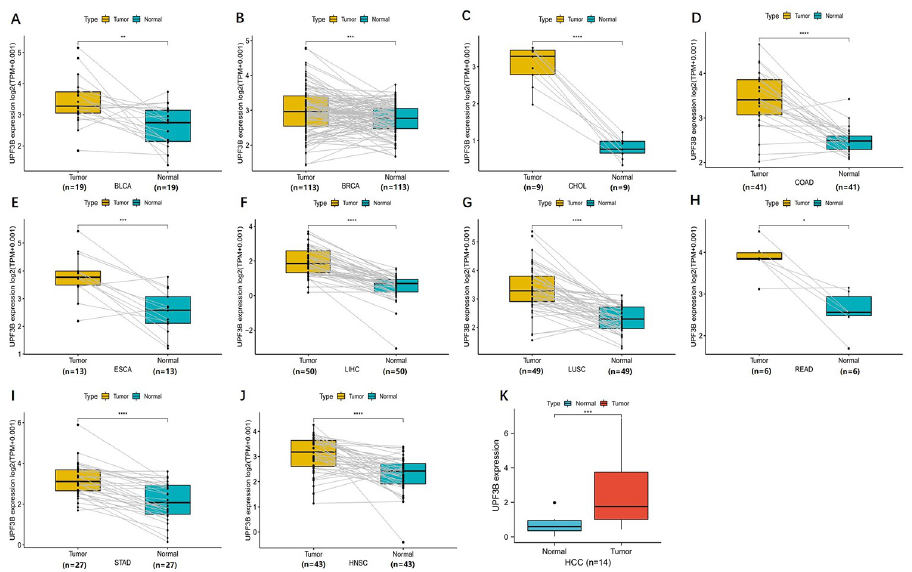
Fig 2. Paired expression analysis of UPF3B in pan-cancer and validate UPF3B expression in liver tumor samples. (A-J) UPF3B expression in indicated paired tumor and normal tissues in pan-cancer data of TCGA. Gray lines connect paired tissues. (K) qRT-PCR results showed the expression of UPF3B in liver cancer tissues. Data was obtained via The Fourth Hospital of Hebei Medical University. � p < 0.05, �� p < 0.01, ��� p < 0.001, ���� p < 0.0001.